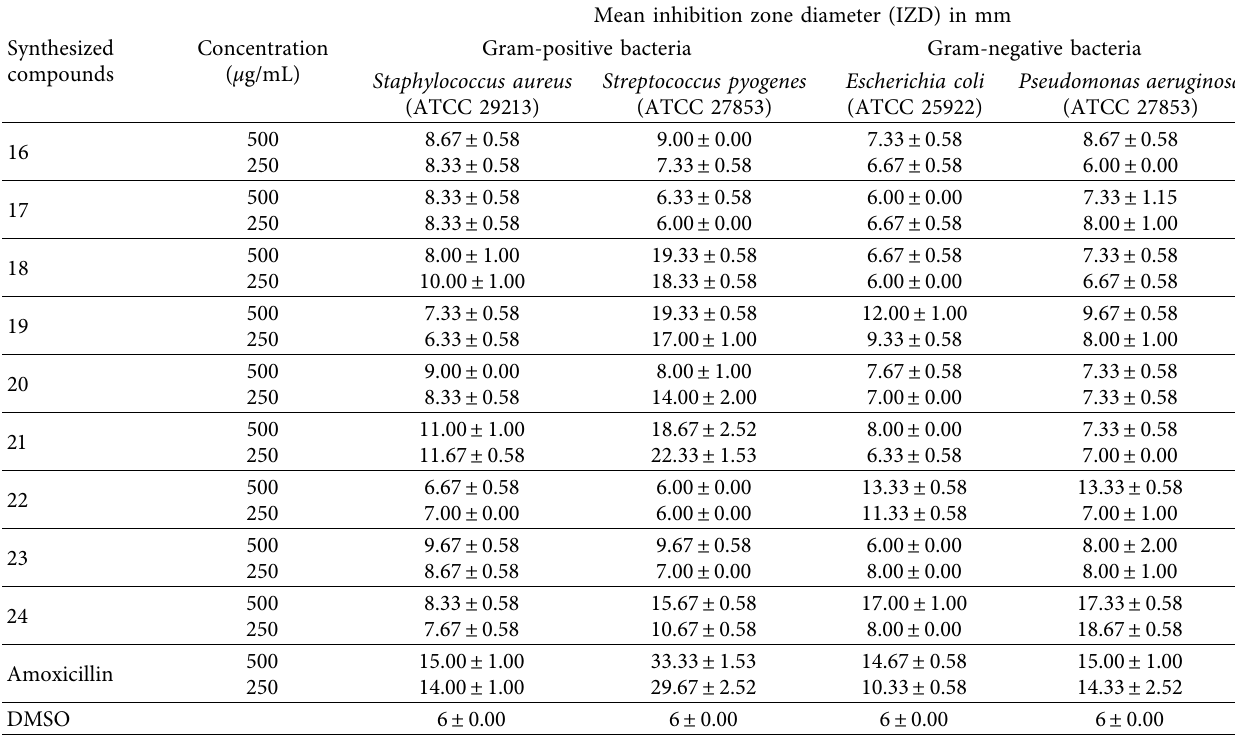
Table 1: Antibacterial activity of compounds 16–24 and amoxicillin against selected Gram-positive and Gram-negative strains. Synthesized